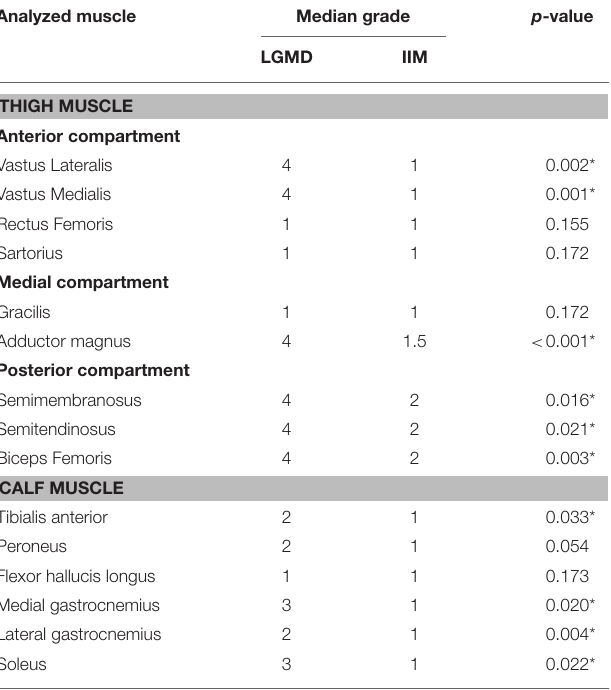
TABLE 4 | Comparison of the grades of muscle edema between limb-girdle muscular dystrophy and idiopathic inflammatory myopathy. Analyzed muscle